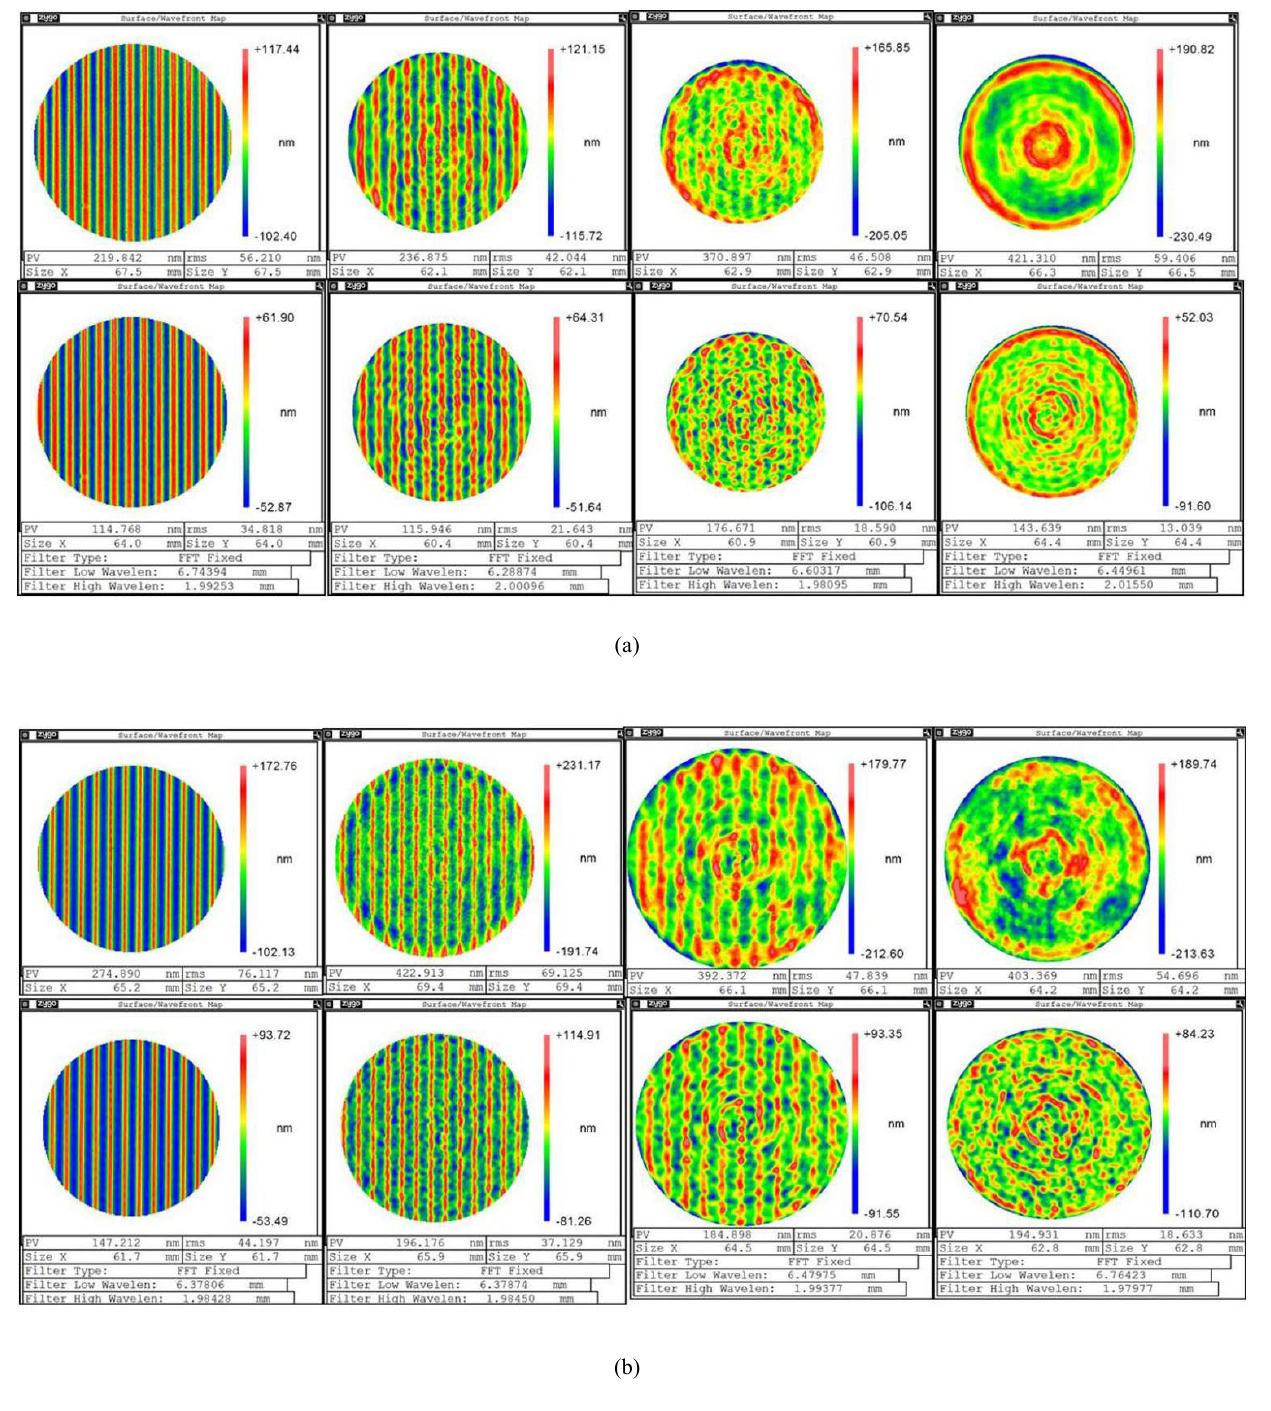
Fig. 15 Selected measured surface errors (top) and filtered data (bottom) in timed sequence: (a) 300-RPM and (b) 400-RPM tool-speed V